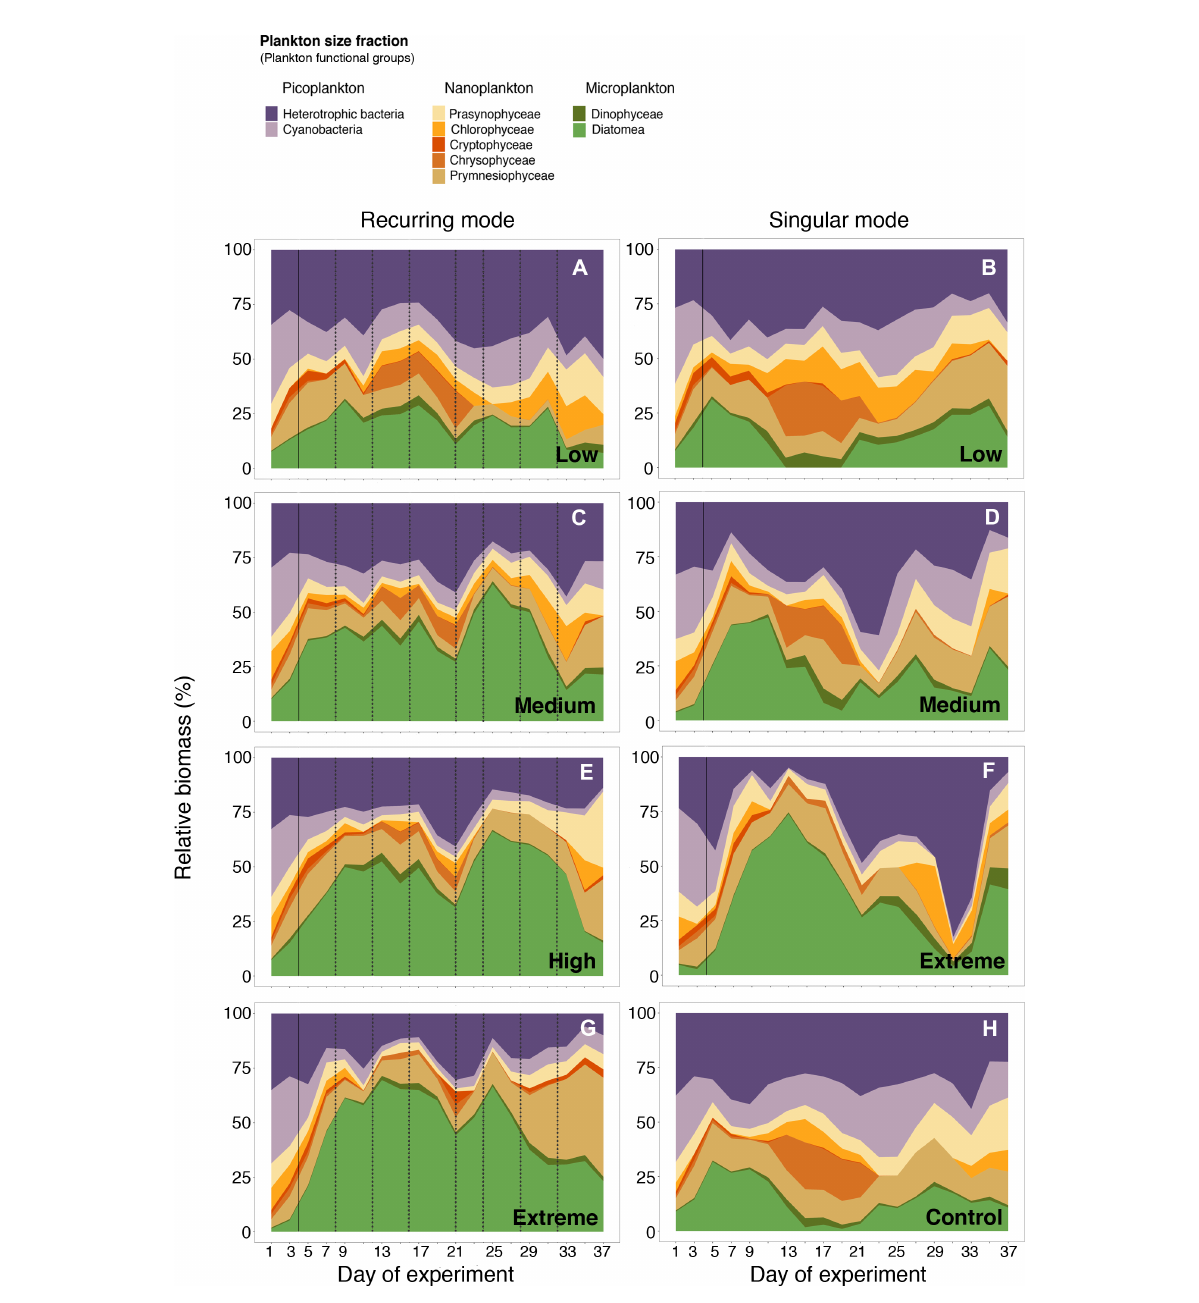
FIGURE 4 Relative contribution of plankton community composition (represented as size fractions: Pico-, Nano- and Microplankton) over the course of the experiment. Picoplankton: heterotrophic bacteria and cyanobacteria; Nanoplankton: prasynophyceae, chlorophyceae, cryptophyceae, chrysophyceae and prymnesiophyceae; Microplankton: dinophyceae and diatomea. The solid black line indicates the fi rst deep-water addition (except in the control). The dotted black lines indicate the addition made only to the recurring treatment. Panels (A , C , E , G) refer to recurring mode, and panels (B , D , F) to singular mode from low to extreme upwelling intensities (respectively). Panel (H) is the